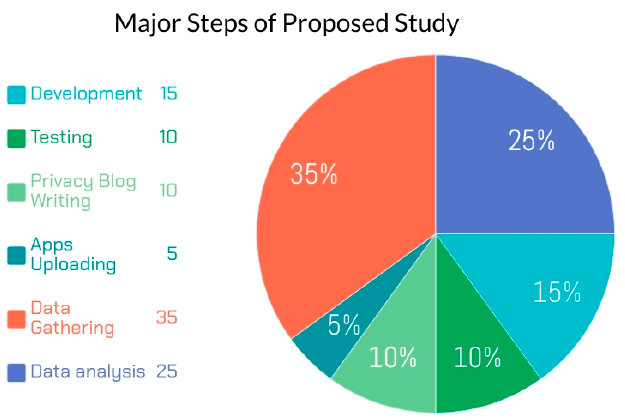
Figure 2. Major steps involved in proposed study.